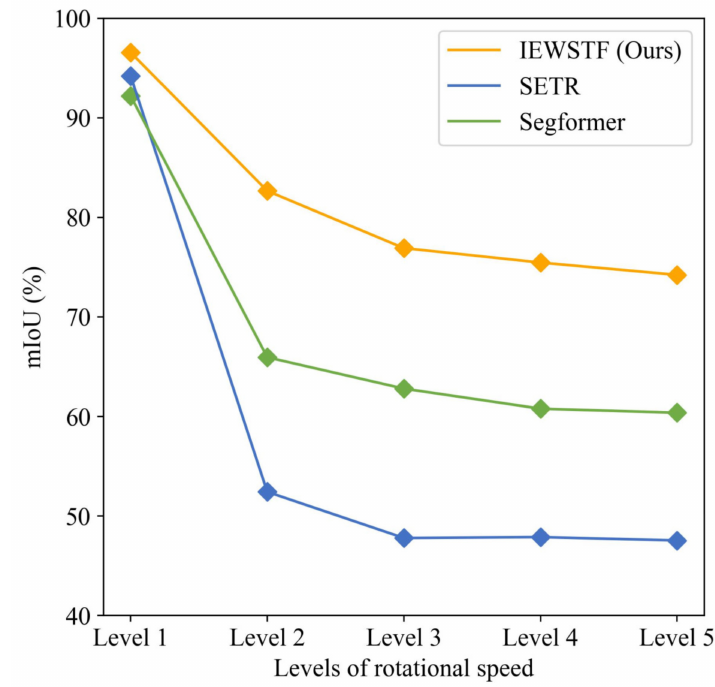
Figure 5. Comparison of mIoU for all methods at different levels of rotational